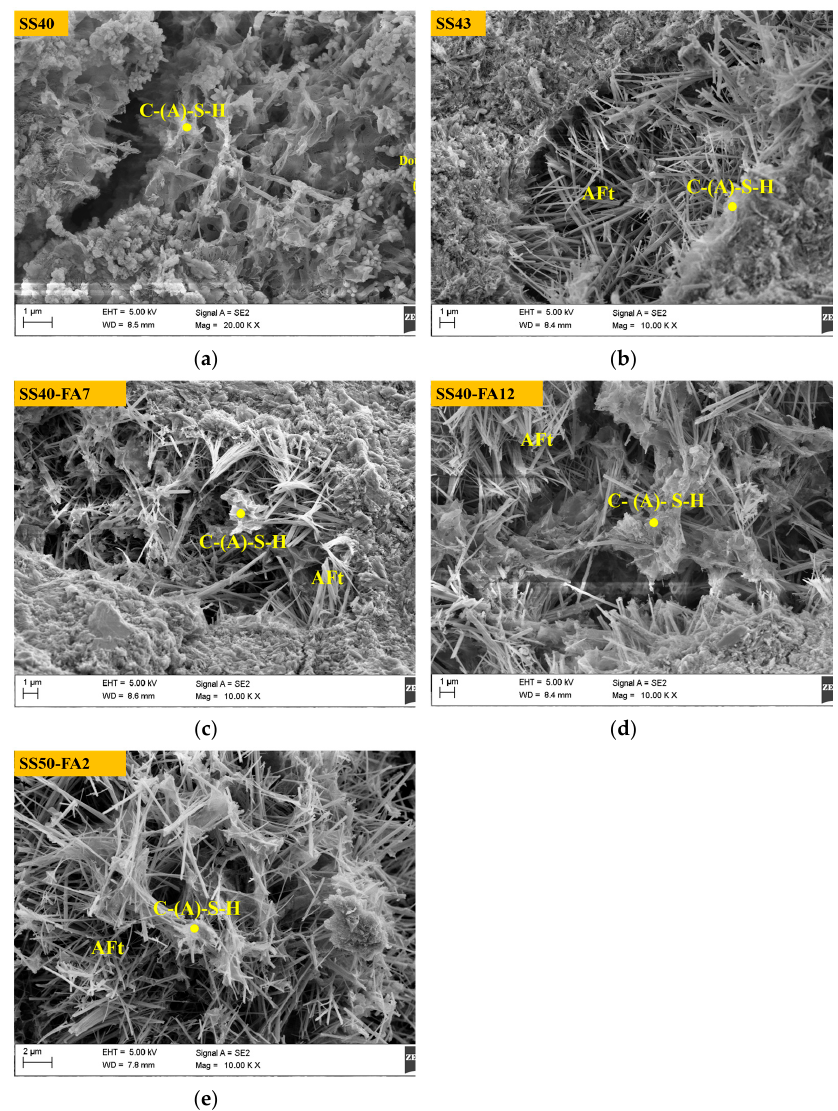
Figure 10. SEM images of SS-based composite cementitious materials at 90 days. The percentages of Ca and Si atoms as well as Ca/Si and Al/Ca atomic ratios in C-(A)- S-H of pastes were explored by EDS analysis at 90 days, as shown in Figure 11. The Ca/Si ratio of C-(A)-S-H gel in cementitious materials is in the range of 1.32–1.84. Relevant works of literature [42–44] suggest that the Ca/Si of C-S-H for cement-based materials ranges from 1.50 to 2.58. SS cementitious materials exhibit a lower Ca/Si ratio of C-(A)-S-H com- pared to cement-based materials. The average silicate chain length of C-(A)-S-H increases with the decrease in the Ca/Si ratio [45]. Longer silicate chains contribute to the develop- ment of mechanical properties [43].